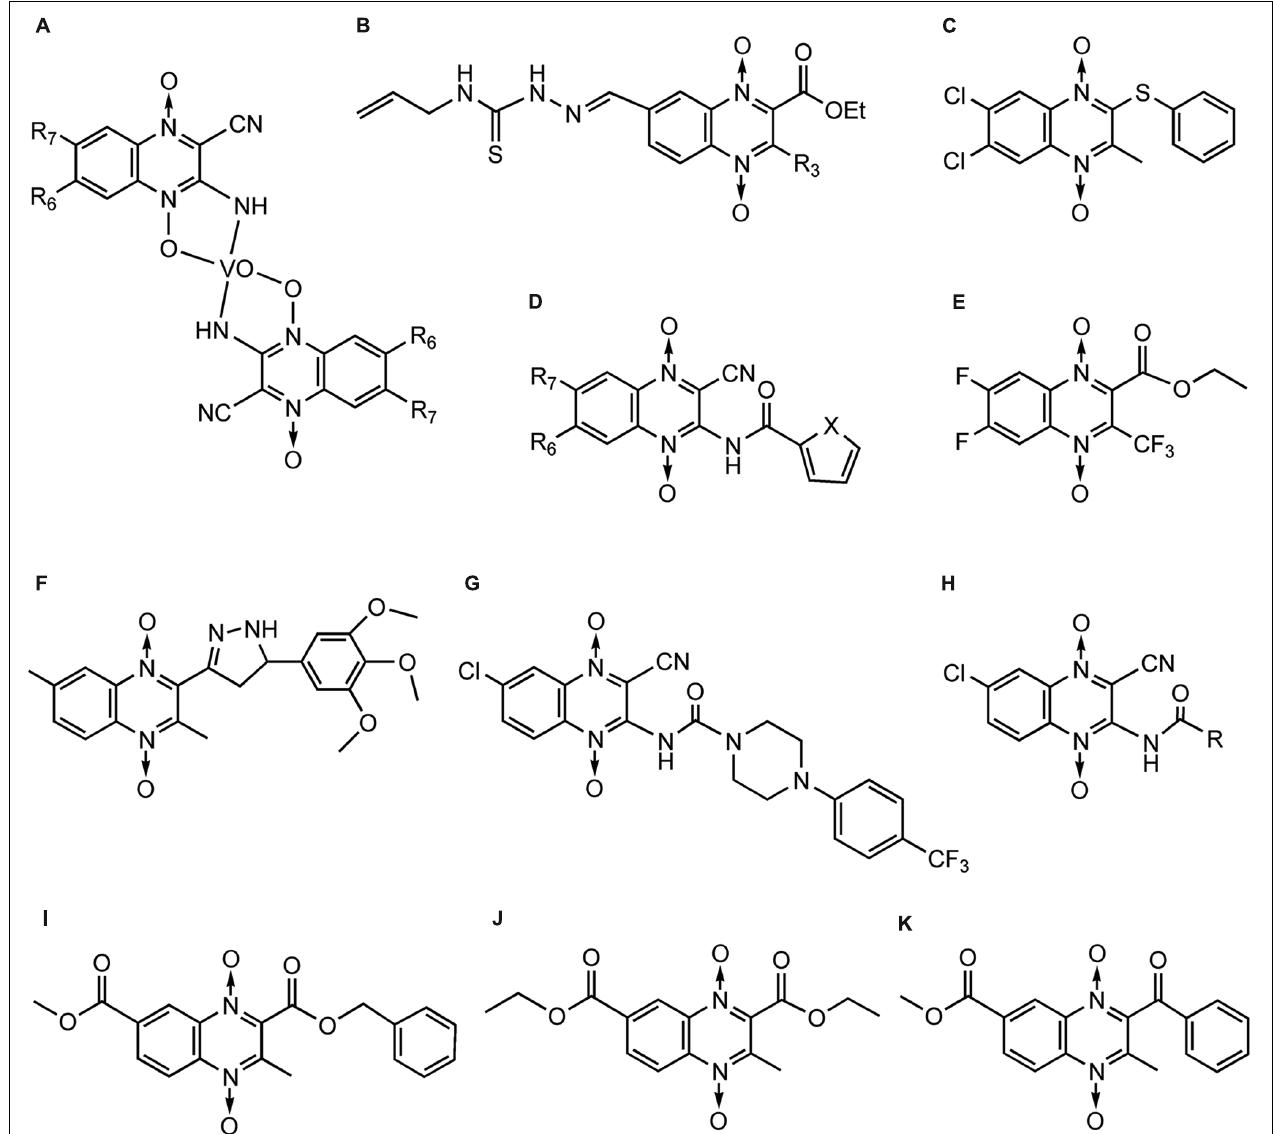
FIGURE 8 | QdNOs with antitrypanosomal activity.